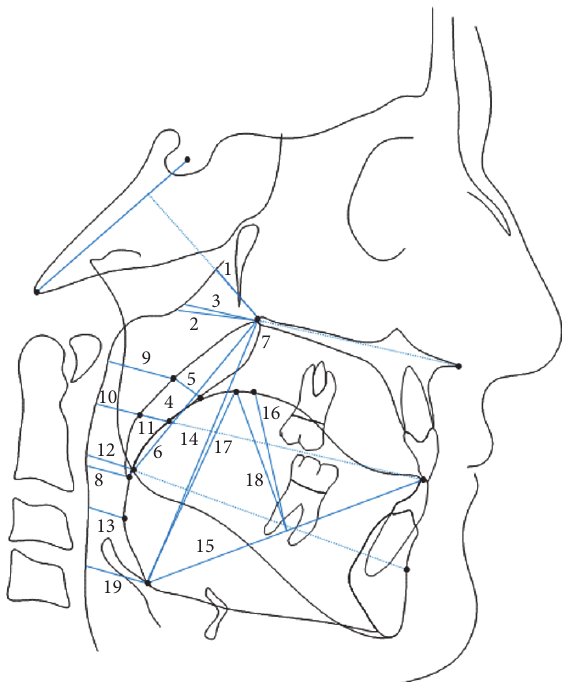
Figure 1: Cephalometric pharyngeal airway space variables divided vertically into (A) nasopharynx : (1) PPW Ad2-PNS (distance between posteriornasalspine(PNS)andtheposteriorpharyngealwall(PPW)alongalineperpendiculartoBa-S),(2)PPWAd1-PNS(distancebetween PNSandPPWalongthelinePNS-Ba),and(3)PPW-PNS(distancebetweenPNSandPPWalongthepalatalplane);(B) oropharynx subdivided into (a) soft palate and retropalatal areas : (4) uvula area, (5) uvula thickness (distance between front and back of uvula at its thickest point), (6) PNS-P (soft palate length from PNS to the lower tip of the uvula), (7) ANS-PNS-P angle (formed by the lines ANS-PNS and PNS-P), (8) PPW-P uvula (distance between uvula tip and the PPW along a line parallel to the palatal plane), (9) PPW-uvula dorsum (distance between uvula dorsum (middistance P-PNS) and PPW along a line parallel to the palatal plane), and (10) PPW-UvOp (distance between uvula dorsum and PPW along the occlusal plane); (b) retroglossal region : (11) PPW-TgOp (distance between the highest point on tongue dorsum and PPW along the occlusal plane), (12) PPW-GoB (distance between gonion and PPW along the line Go-B), (13) PPW-tongue base (distance between the most posterior point on tongue base and PPW along a line parallel to the palatal plane), and (14) Eb-PNS (vertical airway length); (c) tongue : (15) Eb-TT (distance between epiglottis base (Eb) and tongue tip (TT)), (16) TgH (distance between midpoint Eb-TT and the highest point on tongue dorsum), (17) Eb-Tg dorsum (distance between Eb and tongue dorsum), and (18) TgH dorsum (distance between midpoint Eb-TT and tongue dorsum); and (C) hypopharynx including (19) PPW-Eb (distance between Eb and PPW along a line parallel to the palatal